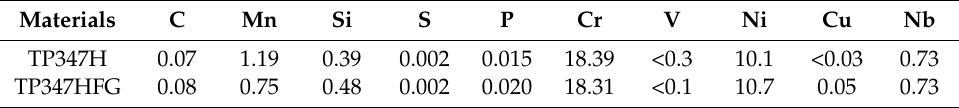
Table 1. Compositions of steels TP347H and TP347HFG